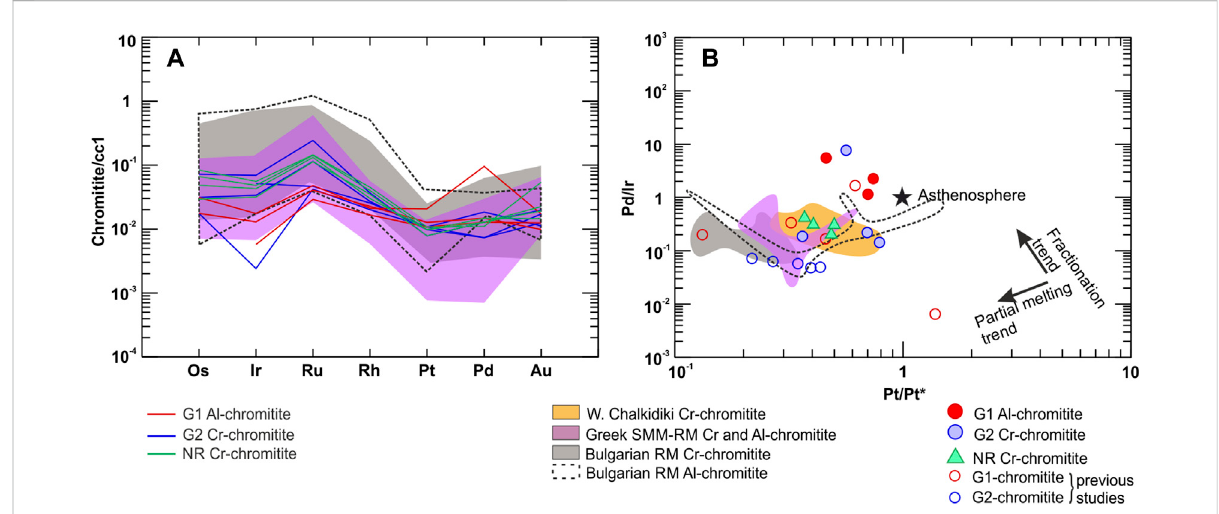
FIGURE 10 (A) ChondritenormalizedPGEpatternsoftheGomatiandNeaRodachromitites,CC1ValuesafterNaldrettandDuke(1980) (B) Pd/Ir vs. Pt/Pt*= Pt N /(Rh N × Pd N ) 1/2 plot of the studied chromitites (after Garuti et al., 1997). Purple fi eld after Economou-Eliopoulos (1996) and references therein; gray fi eld after Tarkian et al. (1991) and González-Jiménez et al. (2015); dotted line fi eld after González-Jiménez et al. (2015); orange fi eld after Economou-Eliopoulos(1996) andSideridisetal.(2021);G1andG2chromititefrompreviousstudiesareafterEconomou-Eliopoulos(1996)and Bussolesi et al.